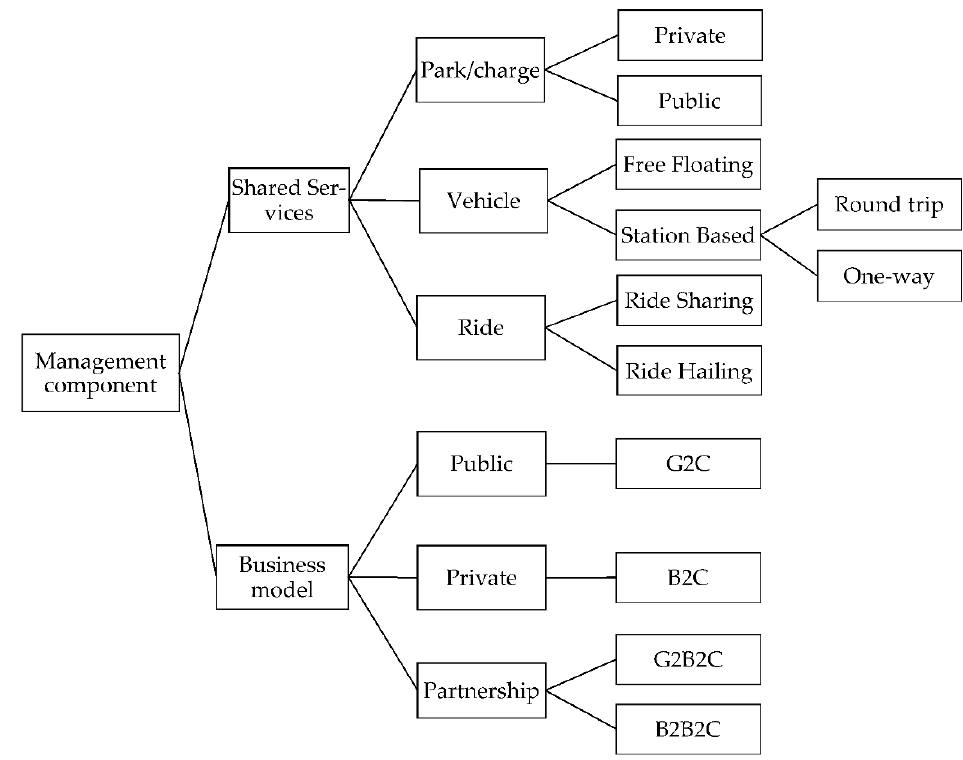
Figure 3. Governance: managerial components.